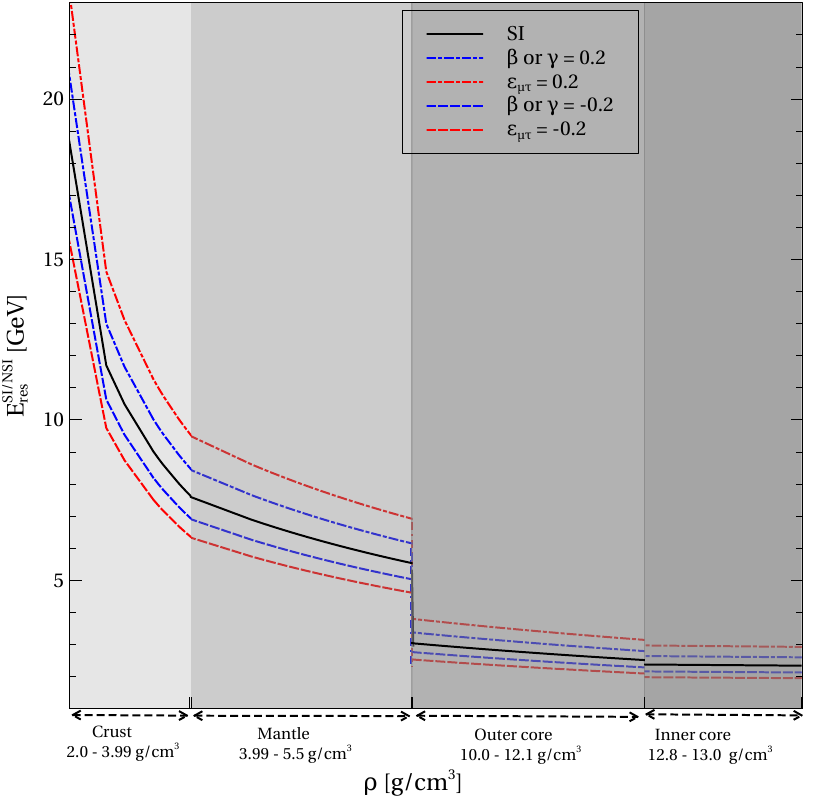
Figure 8 . θ 13 -resonance energy (see eq. (6.5)) as a function of the matter density ρ inside the Earth. The solid black line shows the SI case. The dot-dashed (dashed) lines correspond positive (negative) values of the NSI parameters considering one NSI parameter at-a-time, as shown in the legend. The four grey shaded regions with varying intensity show the four different layers (crust, mantle, outer core, and inner core) and their corresponding densities inside the Earth [99]. The values of the benchmark oscillation parameters used in this plot are taken from table 2. We assume θ 23 = 45 ◦ and